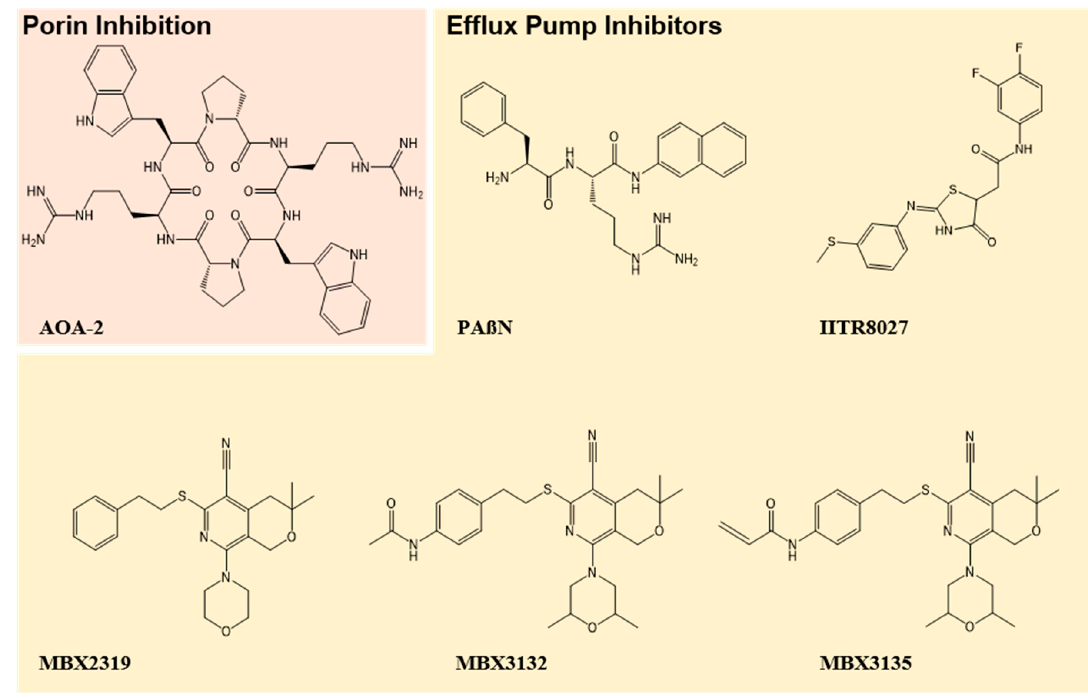
Figure 2. Porin and E ffl ux Pump Inhibitors. Porin (orange) and e ffl ux pump (yellow) inhibitors. AOA-2 represents a promising inhibitor of the porin OmpA in P. aeruginosa. PAßN inhibits the MexAB-OprM e ffl ux pump, whilst the e ffl ux pump inhibitor IITR8027 has been used to re-sensitise A. baumannii to fluoroquinolones. MBX2319 acts upon the RND-type e ffl ux pumps in P. aeruginosa. Its analogues, MBX3132 and MBX3135, were shown to have improved potency and